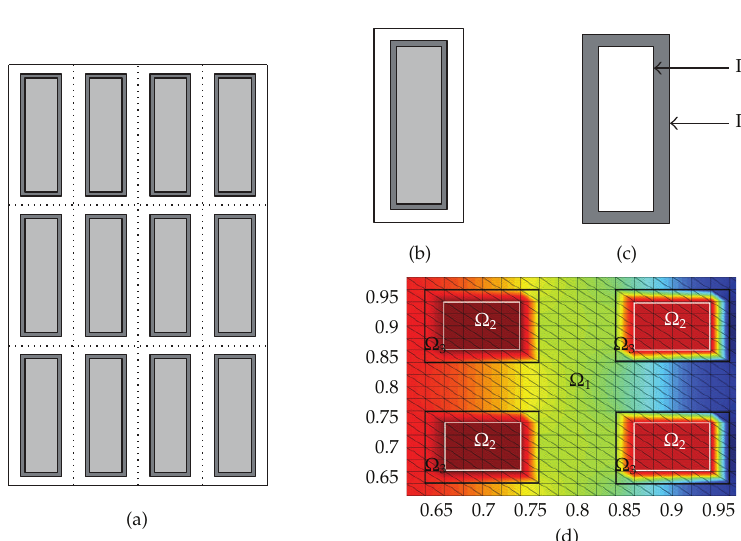
Figure 1: Periodic heterogeneous media. (cid:8) a (cid:9) Ω 1 : white, Ω 2 : grey, and Ω 3 : dark grey. (cid:8) b (cid:9) Zoom of one cell Y : Y 1 : white, Y 2 : grey, and Y 3 : dark grey. (cid:8) c (cid:9) Y 3 in grey with the internal and external boundaries Γ Γ (cid:8) d (cid:9) Illustration of three regions as in Example 3.1, where Ω 2 , 3 , 1 , 3 , respectively. white boundaries, and Ω 3 is the region between by the black and the white